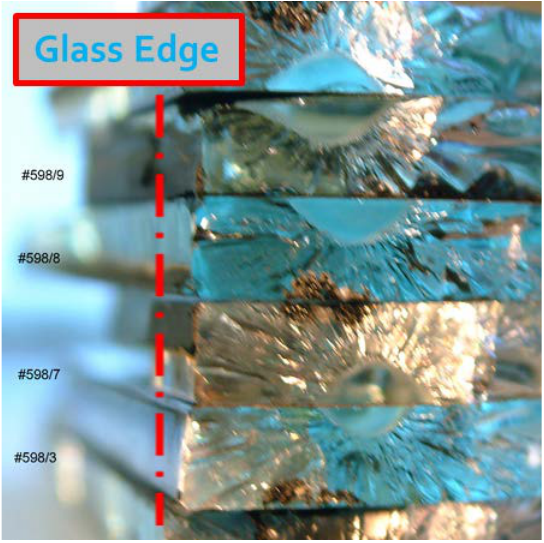
Figure 1. Ceramic enamel frit opacifiers on spandrel glass with the thermal stress fractures beginning away from the glass edge.